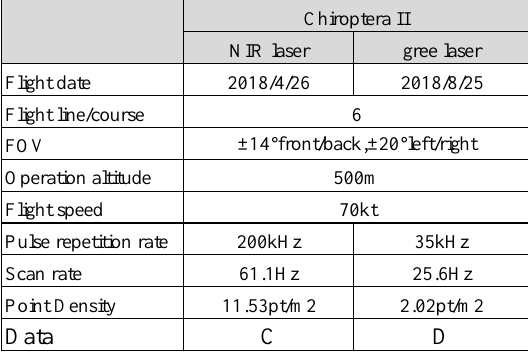
Table 4. Flight details of artificial pool